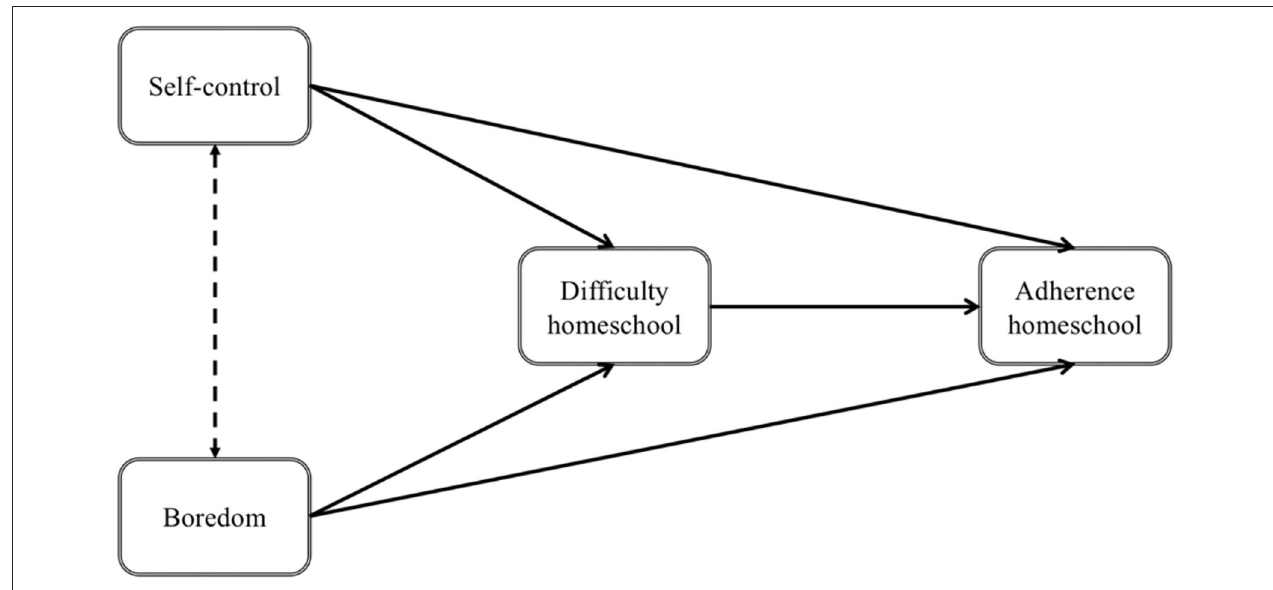
FIGURE 1 | Conceptual model in which the effects of self-control and boredom on adherence are mediated by the perceived difficulty of